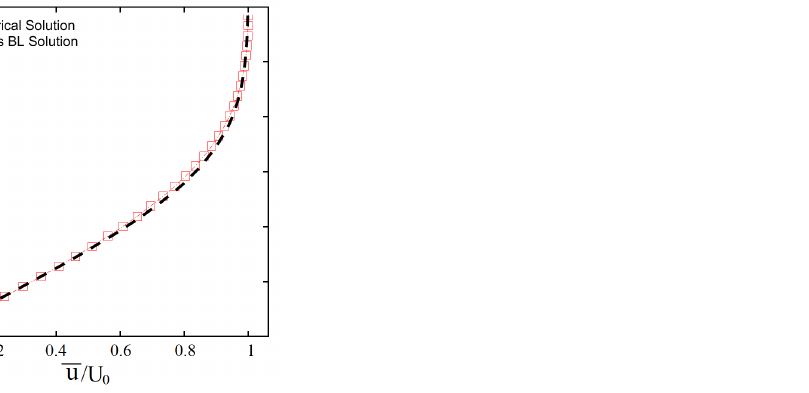
Figure 7. Profiles of time-averaged streamwise velocity profile inside the boundary layer for the long prism at x / h = − 2.1 and y / h = − 7, compared to the Blasius Boundary layer solution.